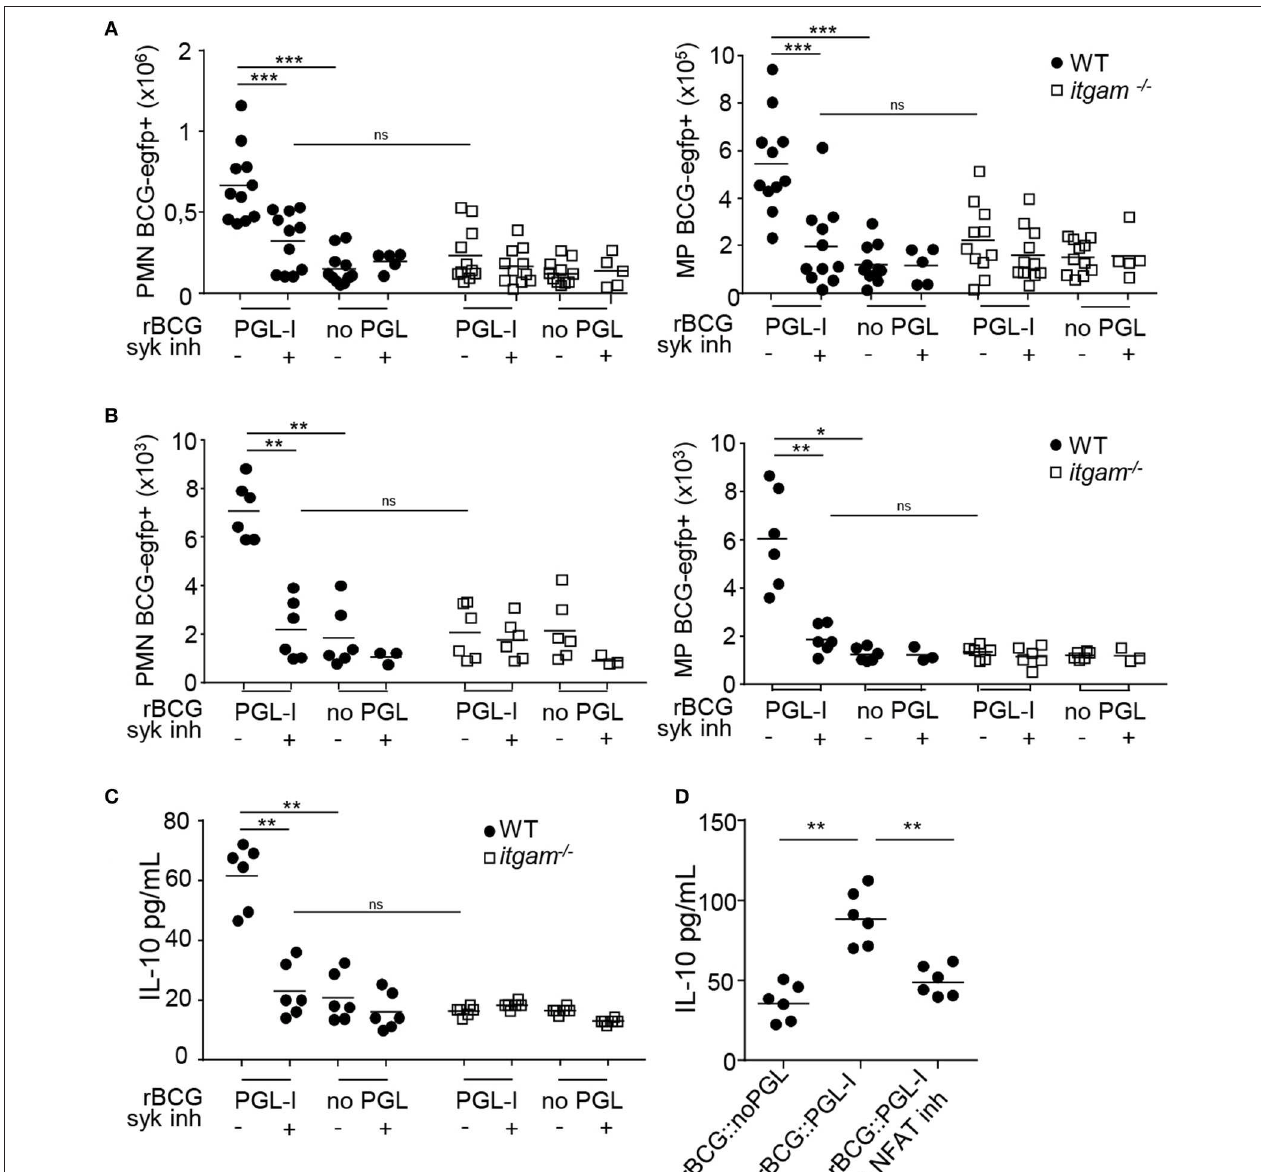
FIGURE 6 | rBCG::PGL-I targeting CR3 triggers Syk and NFATc in vivo . (A,B) WT and itgam − / − mice were nasally infected with 5 × 10 6 CFUs of fluorescent rBCG::PGL-I or rBCG::noPGL, and received two nasal doses of Syk inhibitor GS-9973 administered 1h before and after bacteria. BAL and lung tissues were harvested 24h later to analyze cells by flow cytometry. (A,B) Numbers of Ly-6G + , CD11c − PMNs and Ly-6G − , CD11c + MPs harboring BCG-EGFP + recovered from the lung parenchyma from 11 individuals (A) or BAL from 12 individuals pooled per 2 (B) . (C) IL-10 produced in situ by lung cells was analyzed by ELISA in the first BAL from 12 individuals pooled per 2. (D) WT mice received two nasal doses of CsA 1h before and 1h after rBCG::PGL-I or rBCG::noPGL inhalation, to block NFATc translocation. IL-10 produced in situ by lung cells was analyzed as in (C) . Data are represented as individual values from n = 11 (A) or n = 6 (B–D) from two independent experiments. ** P < 0.01; *** P <